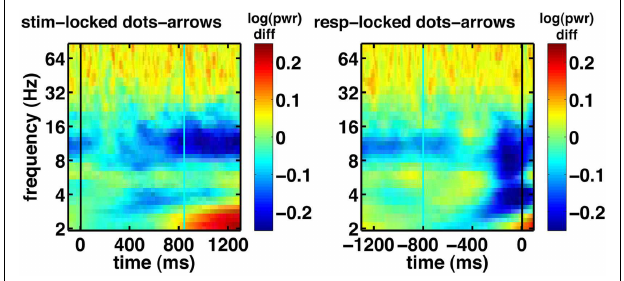
FIGURE 7 | Basic electrophysiological data for electrode FPz. Black line indicates the event to which the data are aligned (onset of dot-motion for the stimulus-locked graphs and the response for the response-locked graphs). Cyan line indicates the average response time and stimulus onset time, respectively.These are difference spectrograms contrasting the integration and non-integration conditions. Left column: stimulus-locked. Right column: response-locked.